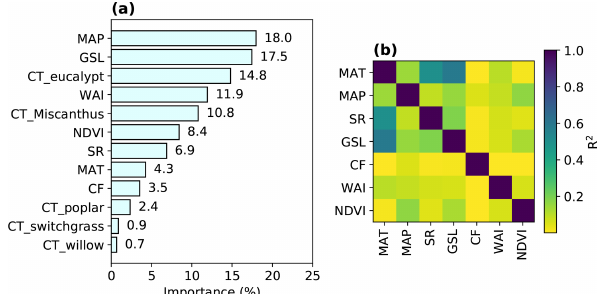
Figure 2. Variable importance in the trained RF model (a) and R 2 from the regressions between different explanatory variables (Ta- ble 1) in the training data (b) . The importance of one variable is cal- culated based on the sum of the number of splits across all trees that include this variable, weighted by the number of samples it splits. The relative contributions of each explanatory variable (summed to 100%) are shown